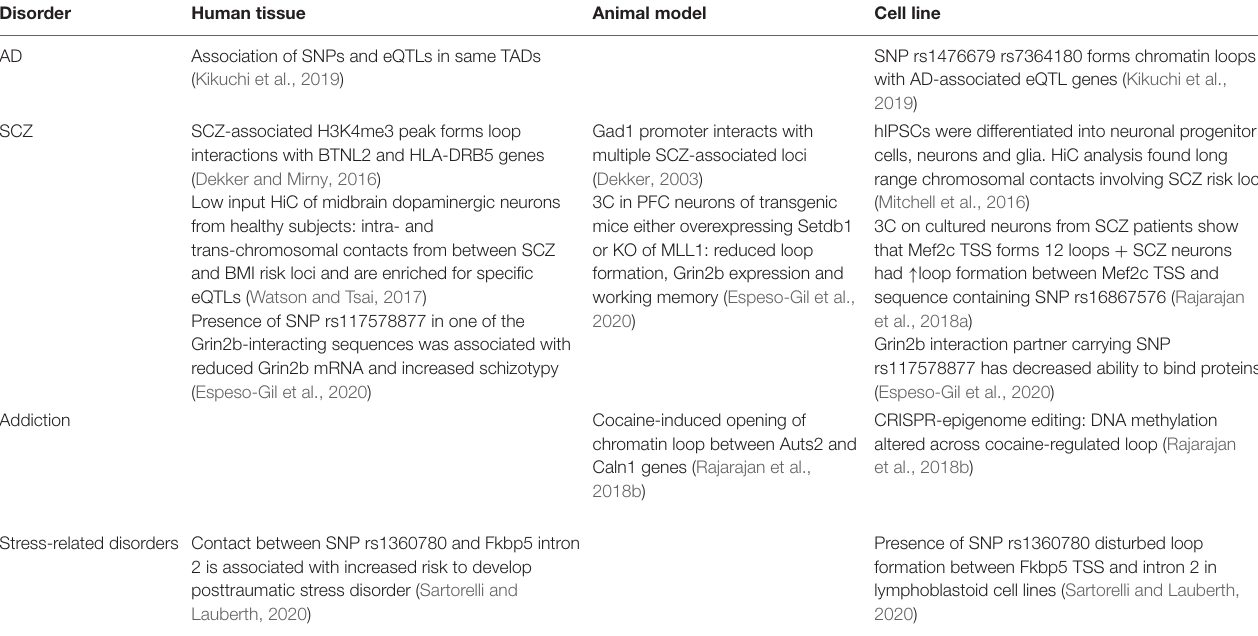
Gad1 promoter interacts with hIPSCs were differentiated into neuronal progenitor multiple SCZ-associated loci cells, neurons and glia. HiC analysis found long (Dekker, 2003) range chromosomal contacts involving SCZ risk loci 3C in PFC neurons of transgenic (Mitchell et al., mice either overexpressing Setdb1 or KO of MLL1: reduced loop formation, Grin2b expression and working memory (Espeso-Gil et al.,